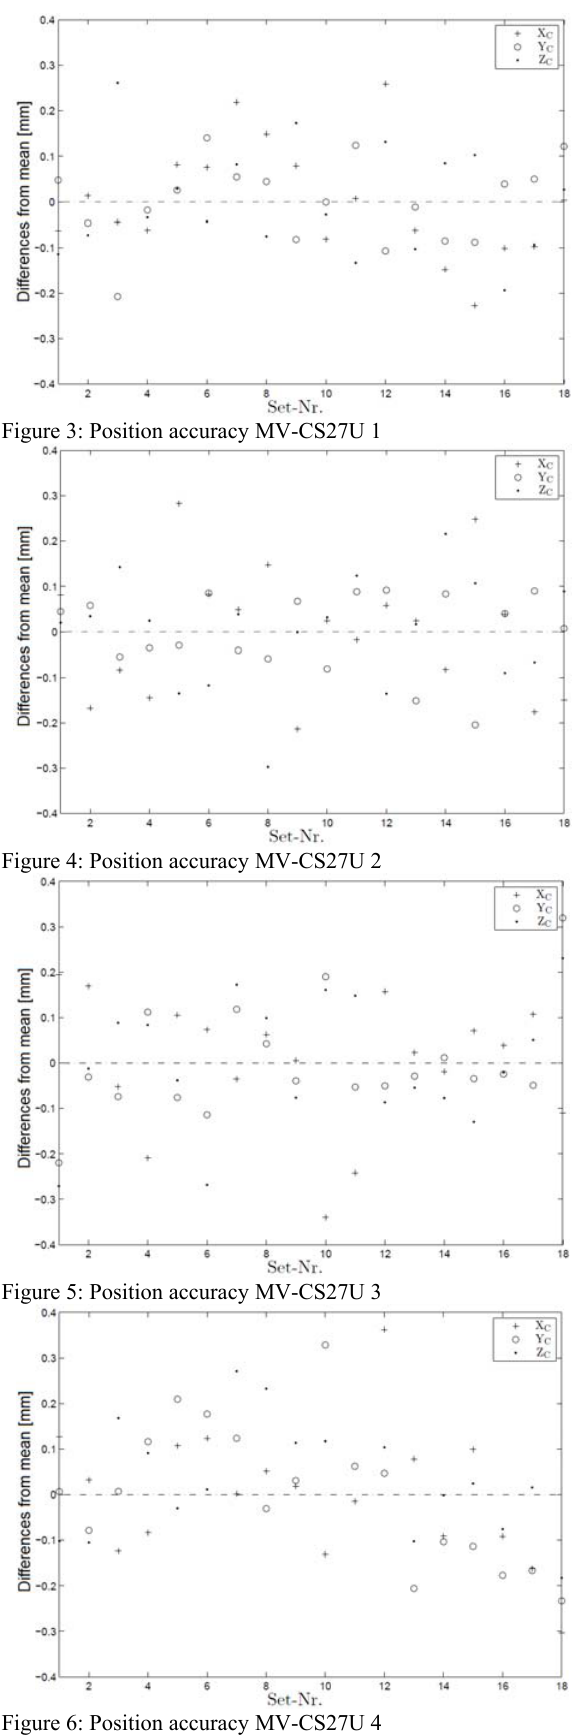
Figure 6: Position accuracy MV-CS27U